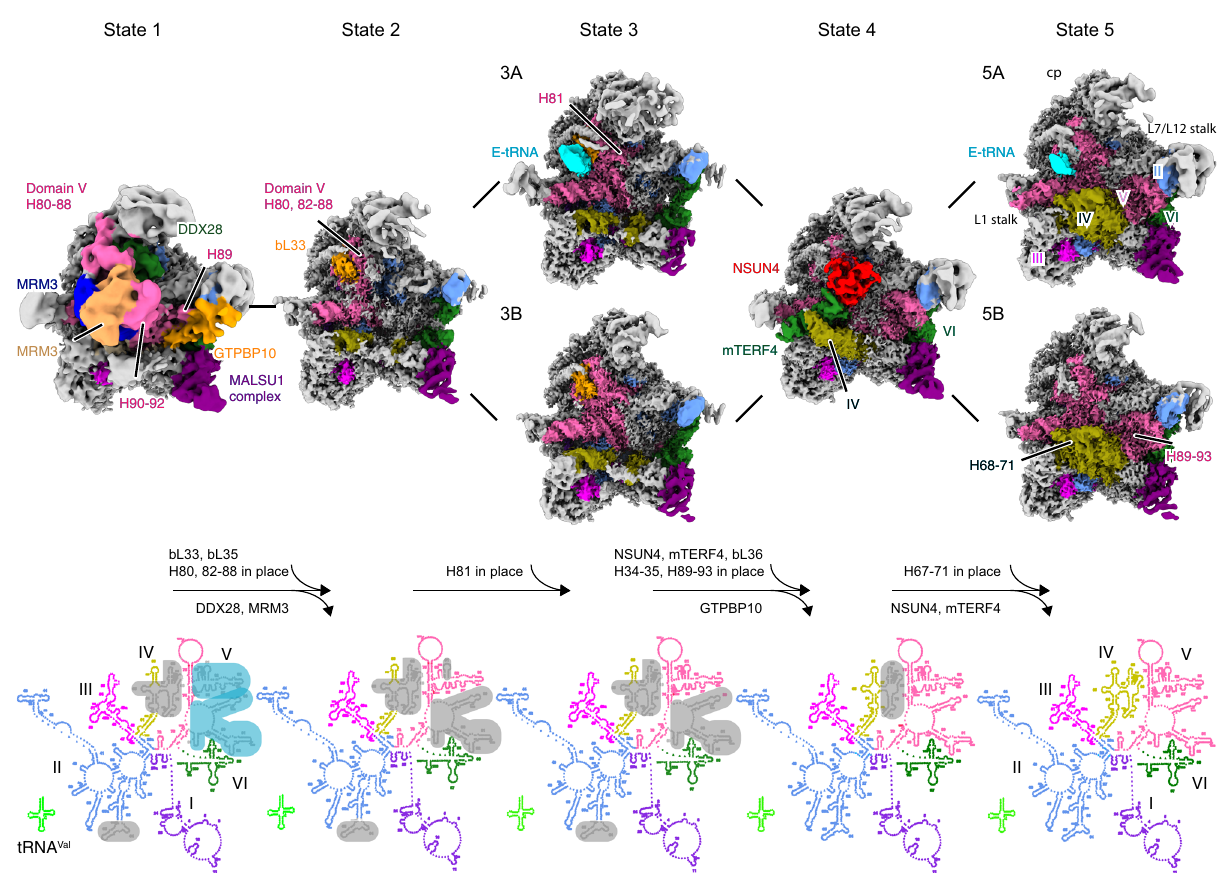
Fig. 1 Ensemble of late human 39S mitoribosome assembly intermediates. Cryo-EM maps of seven different intermediates of the 39S mitoribosome (top row) are shown with the 16S rRNA secondary structures corresponding to states 1 – 5 (bottom row). All assembly factors (MRM3: blue and sandy brown, DDX28: green, GTPBP10: orange, NSUN4: red, mTERF4: green, MALSU1 complex: purple) and six subdomains of the 16S rRNA are color coded (domain 1 – 6: purple, blue, magenta, yellow, hot pink, and green) and ribosomal landmarks indicated (cp, central protuberance). Immature or unstructured regions of the rRNA are shaded in light blue and gray in the secondary structure schemes, respectively. All maps were fi ltered to local resolution using